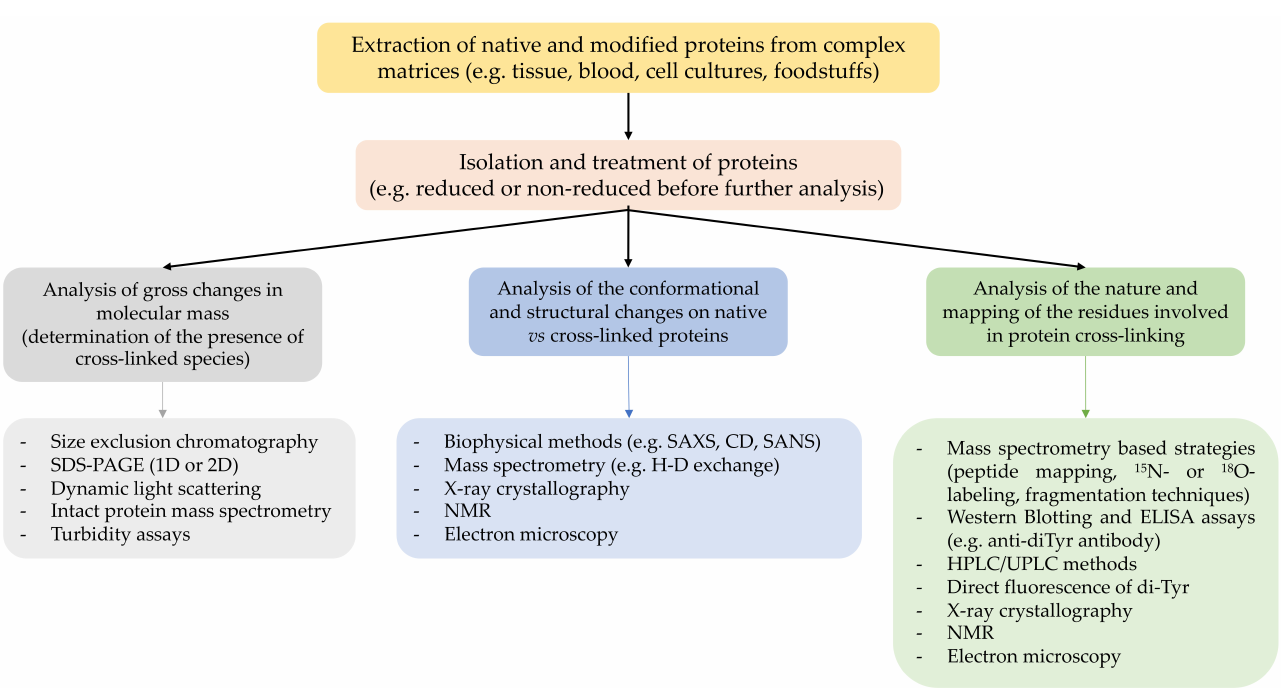
Figure 8. Overview of methods to detect and characterize crosslinked proteins and the sites/types of modifications. Abbreviations used: CD: circular dichroism, SANS: small angle neutron scattering, SAXS: small angle X-ray scattering, H–D: hydrogen–deuterium exchange mass